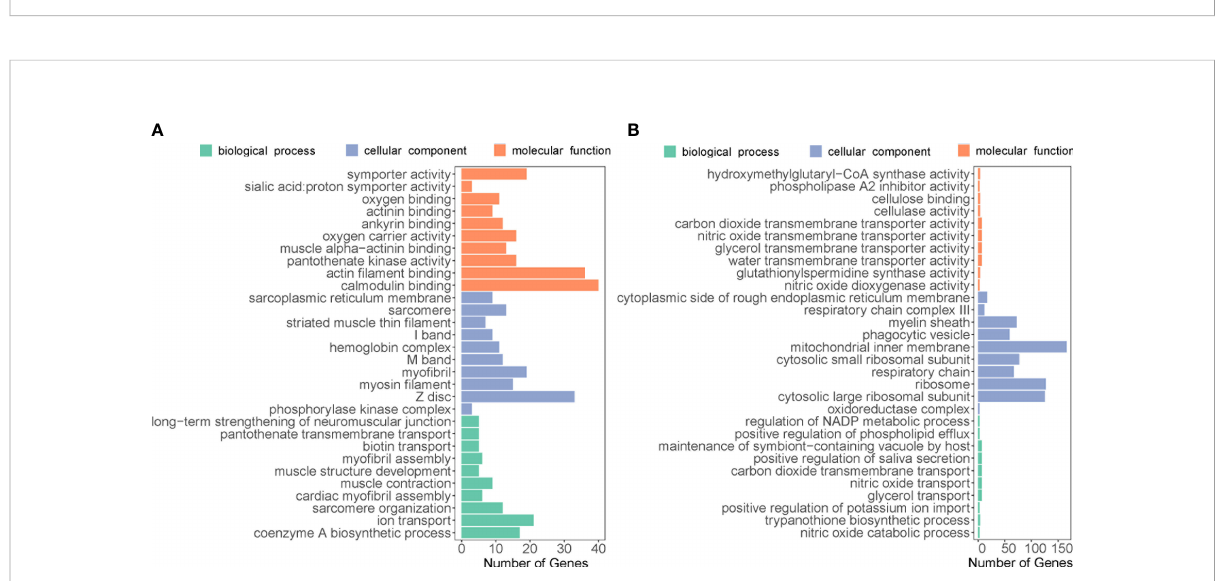
FIGURE 7 Top 30 enriched Gene Ontology categories associated with upregulated genes in (A) Sternaspis chinensis and (B) Sternaspis liui syn. n.